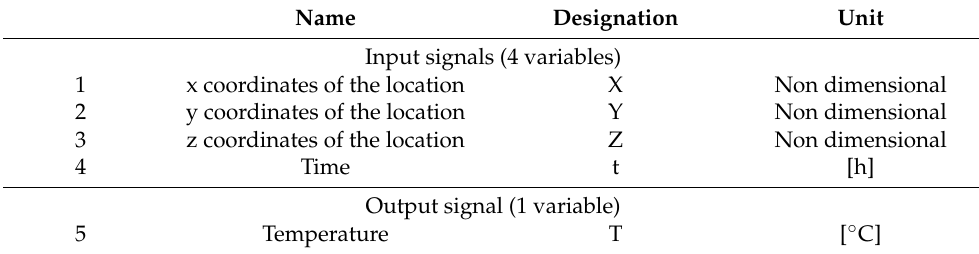
Table 1. Input and output variables.